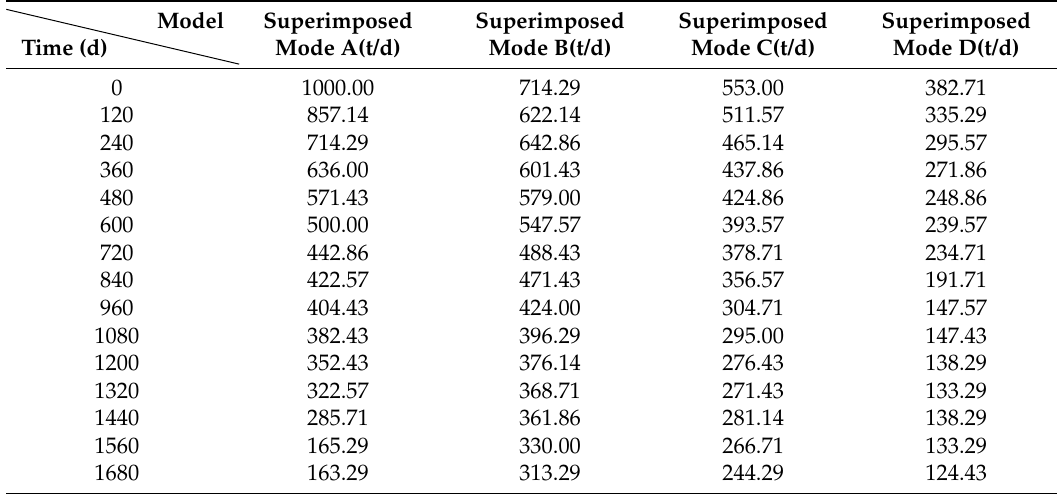
Table 3. The production data of four superimposed